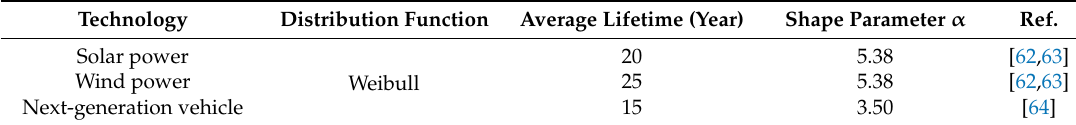
Table 2. Average lifetime of low carbon technology.